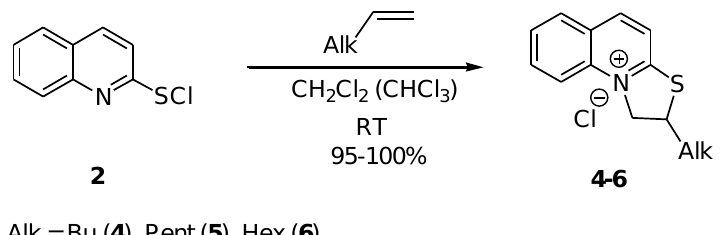
Scheme 4. The synthesis of 2-alkyl-1,2-dihydro[1,3]thiazolo[3,2- a ]quinolin-10-ium chlorides 4 – 6 by the reactions of sulfenyl chloride 2 with 1-hexene, 1-heptene and 1-octene.